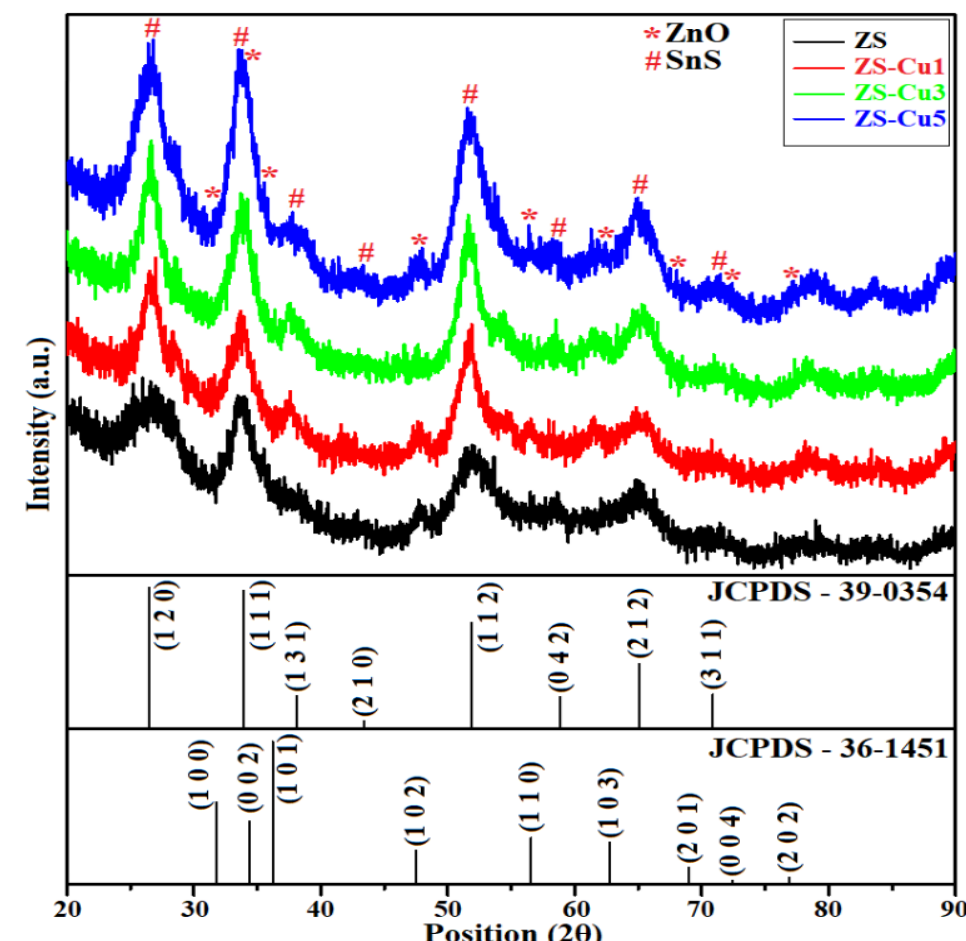
Figure 1. X-ray diffraction patterns of undoped and Cu 2+ -doped ZnO–SnS nanocomposites.